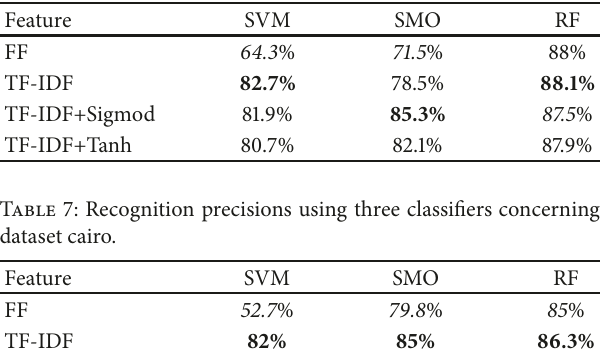
Table 6: Recognition precisions using three classifiers concerning dataset tulum2009.